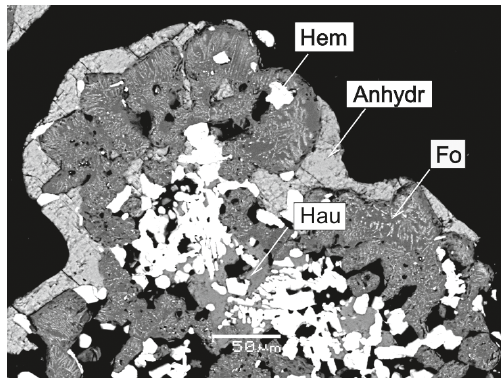
Figure 3. Red forsterite (saturated with hematite inclusions) in- timately associated with hauyne (Hau) and hematite (Hem) and covered by a crust of anhydrite (Anhydr). Arsenatnaya fumarole. Backscattered electron (BSE)